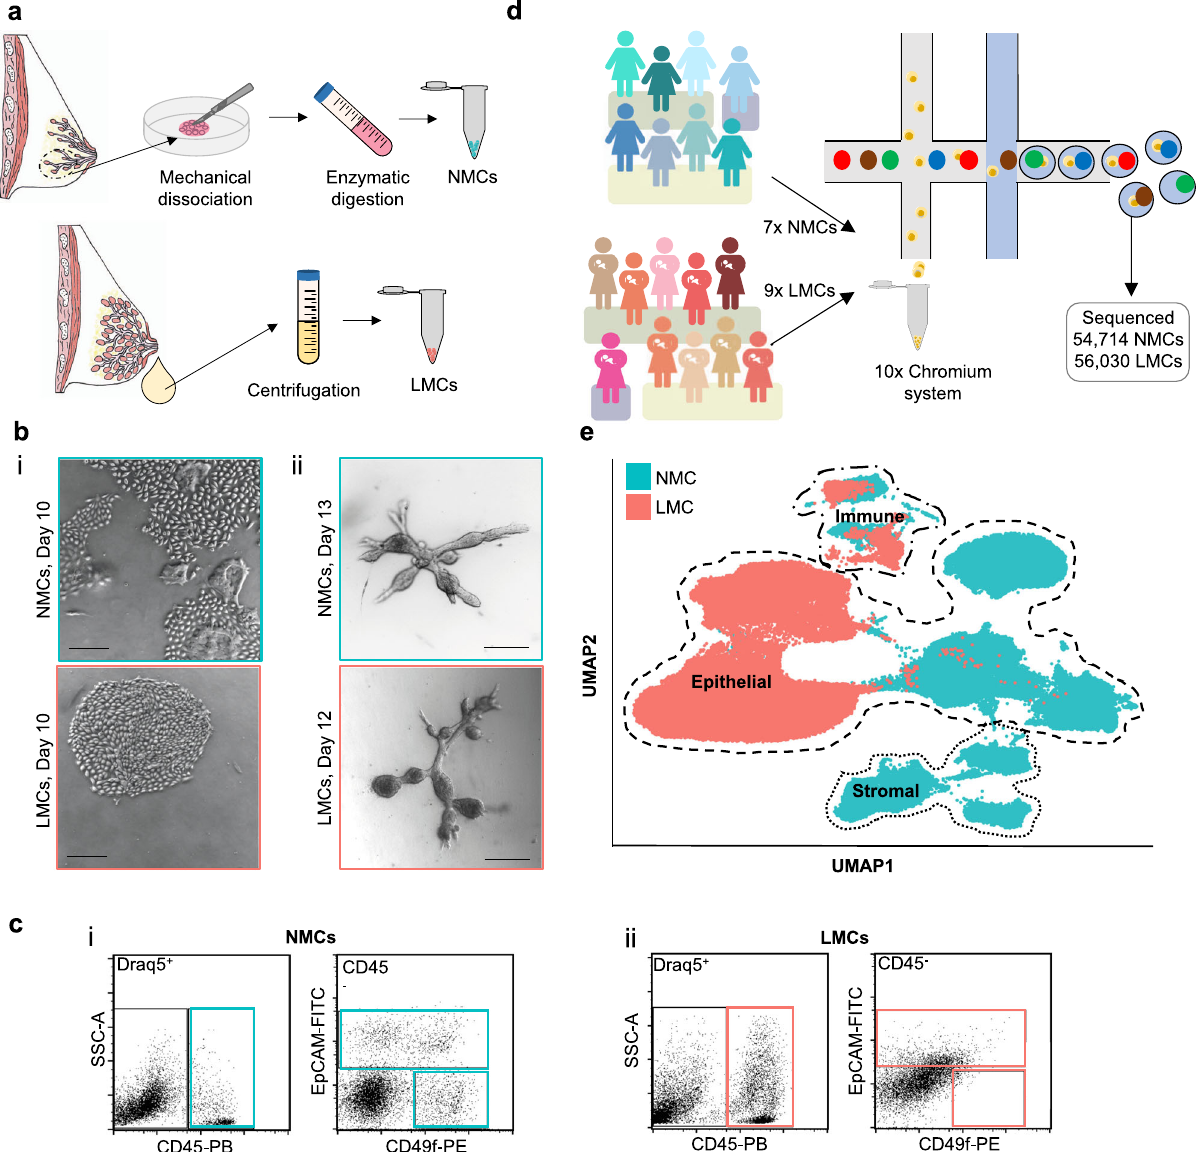
Fig. 1 Exploring the diversity between non-lactating mammary cells (NMCs) and lactation derived mammary cells (LMCs). a Cells from non-lactating tissue (above) and human milk (below) were isolated using either mechanical dissociation and enzymatic digestion or centrifugation, for downstream analysis. b Mammary cells from both non-lactating breast tissue (top) or lactating milk cells (bottom) were cultured either in i 2D ( n = 10, see Supplementary Fig. 2) or ii 3D, scale bar represents 250 μ m. c Representative fl ow cytometric pro fi les of immune/stromal (Draq5 + /CD45 + ), luminal (Draq5 + /EpCAM + /CD49f + / − ) and myoepithelial cells (Draq5 + /EpCAM − /CD49f + ) from i NMCs and ii LMCs. d Schematic diagram for the scRNA-seq experimental set-up for cell samples from seven non-lactating participants and nine lactating females. e Uniform manifold approximation and